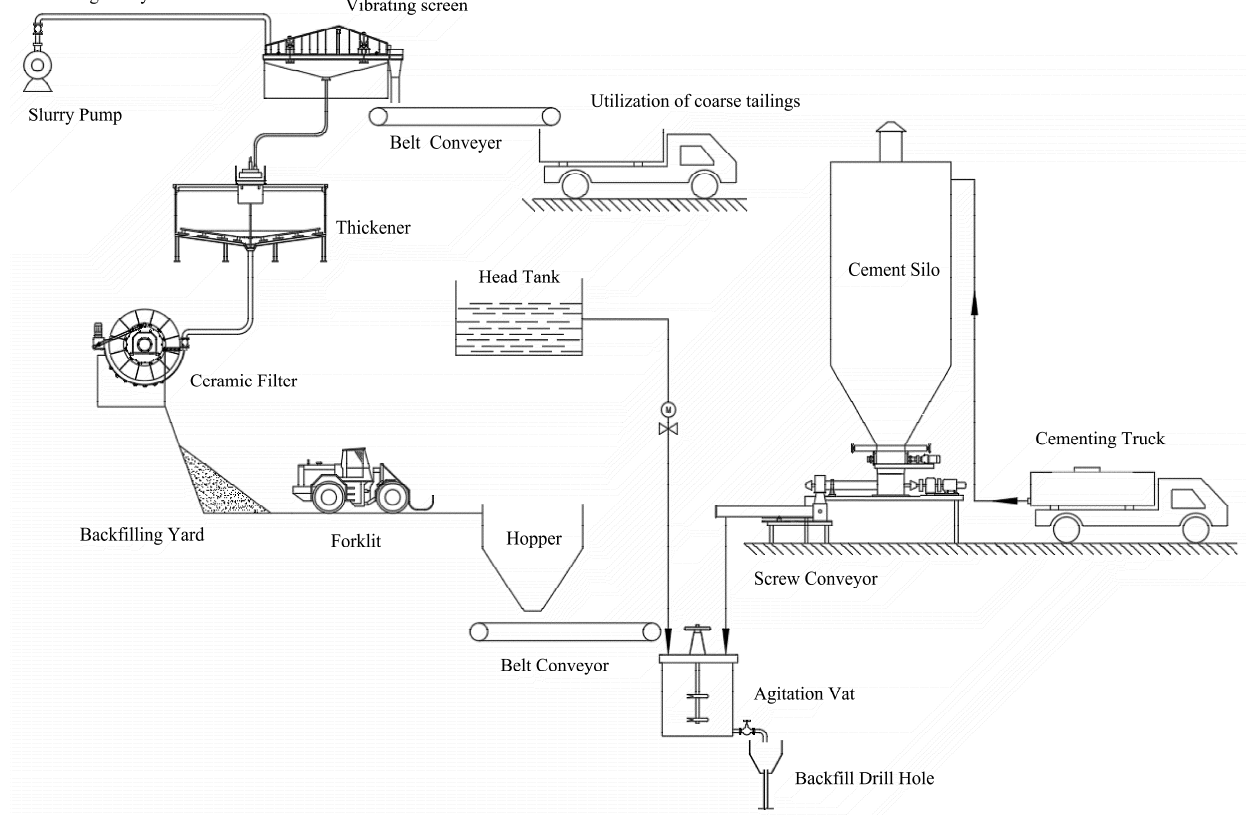
Figure 2. (Source elaborated by authors) Process flow of fine particle size grading tailings backfill system.